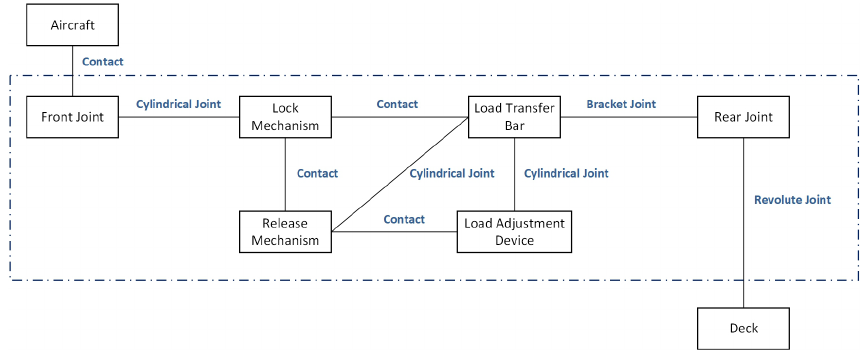
Figure 4. Sketch of holdback bar connection relationship and kinematic